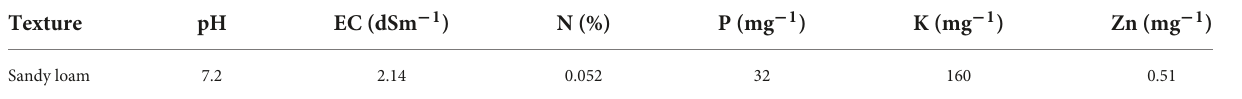
TABLE 1 Physico-chemical properties of soil taken for experiment.